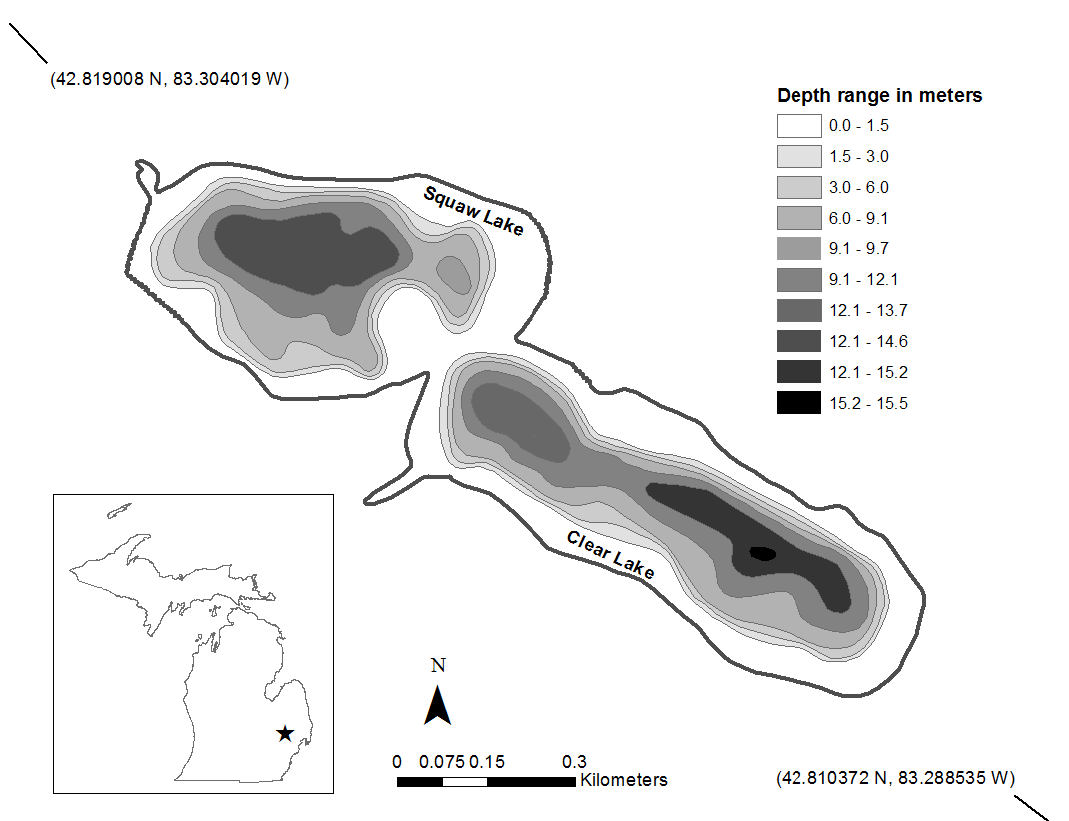
Figure 1. Map of Squaw Lake, Oakland County, MI,